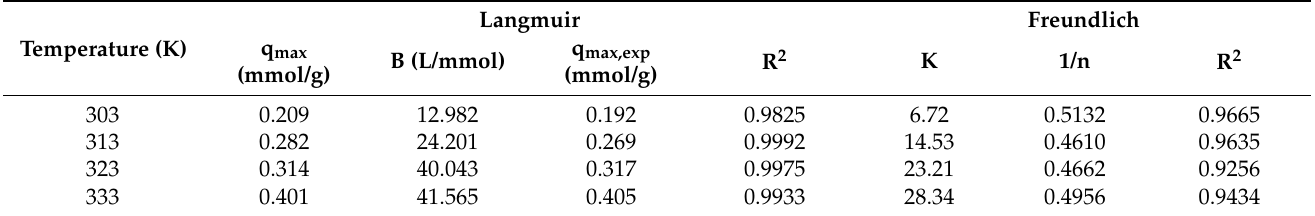
Table 1. Langmuir and Freundlich parameters of UO 22+ adsorbed on PA-BWT.